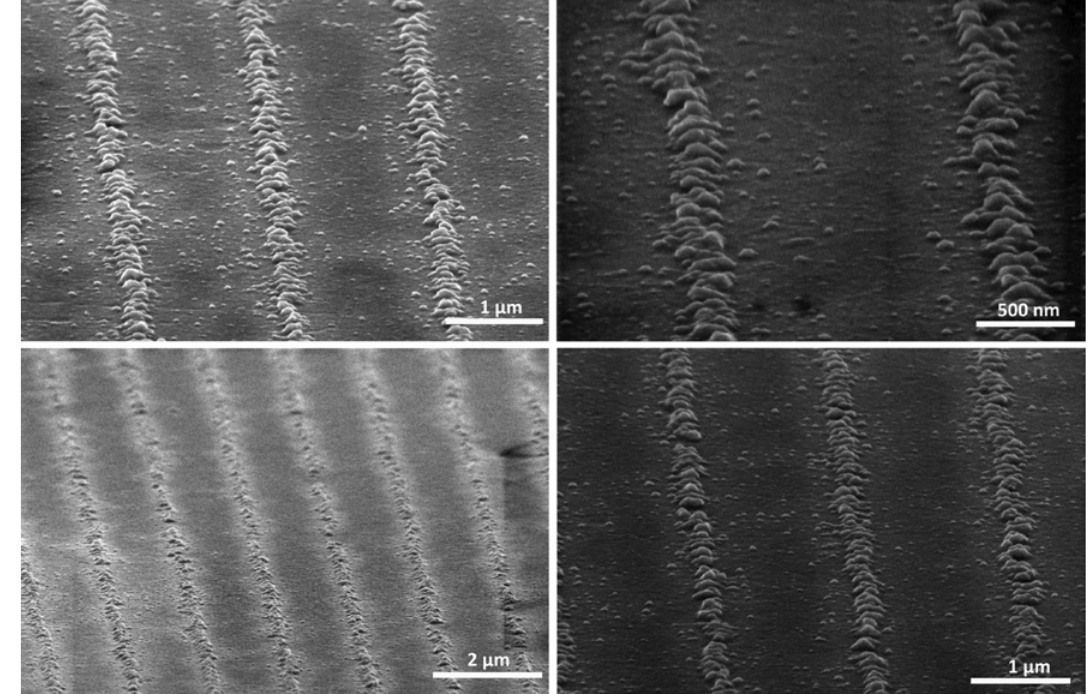
Figure 4: Scanning electron micrographs of AgNPs on 100 nm polystyrene film growing above the